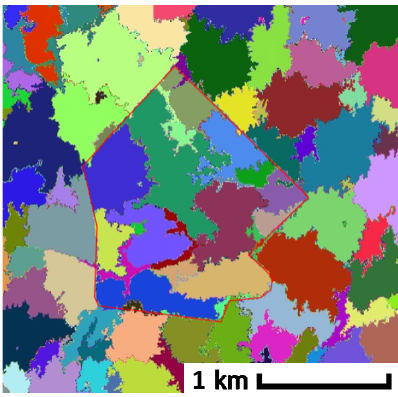
Figure 4. An example of SNIC clustering. The red contour represents the shape of the deforested